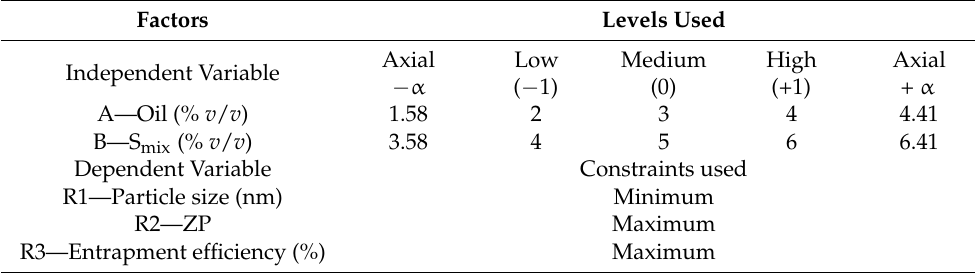
Table 3. Variables used in CCRD to optimize the